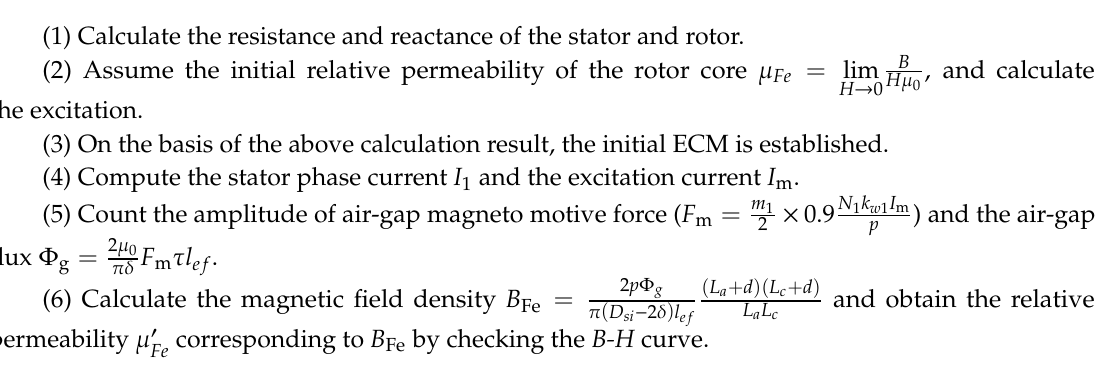
Figure 8. Computational program diagram of ECM.